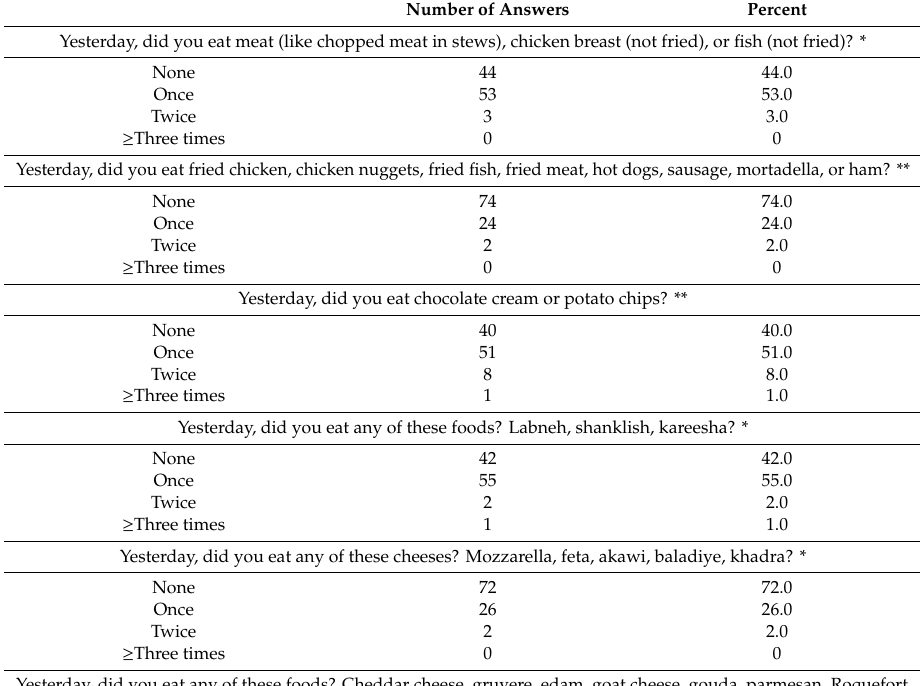
Table A10. Answers to the dietary adherence questionnaire per question by parents. Number of Answers